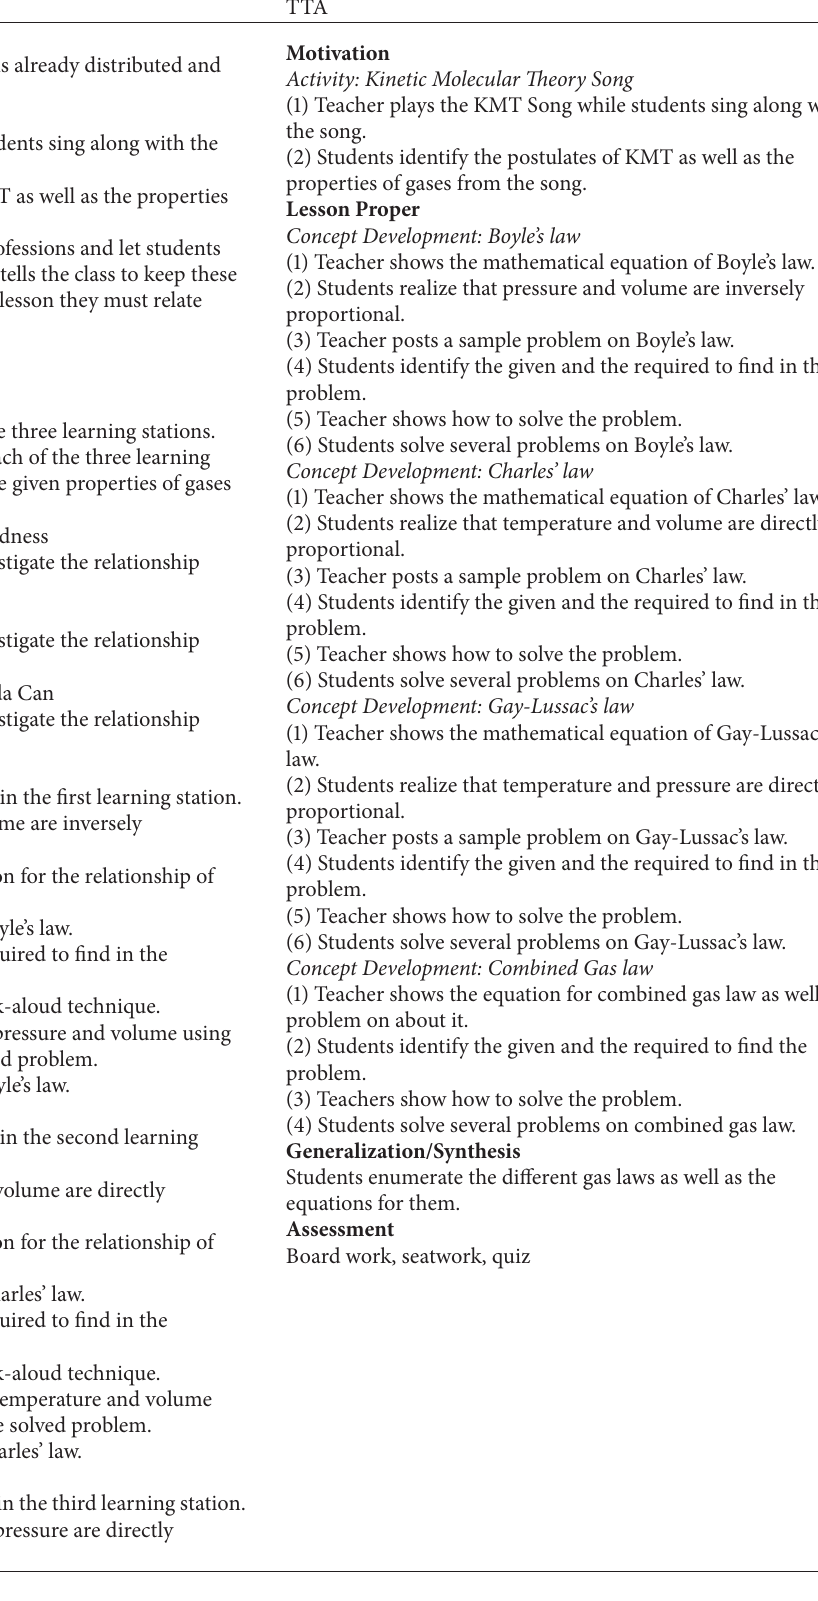
Table 3: Learning plan comparison between the COPT and TTA classes on the topic gas laws. COPT